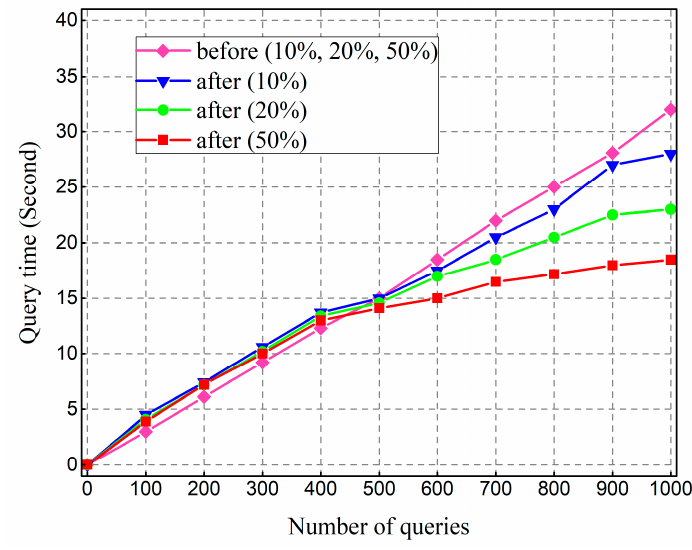
Figure 7. Test results of query optimization.